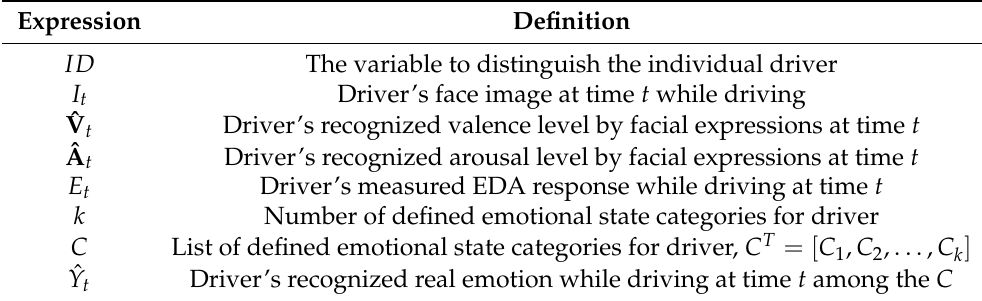
Figure 1. Overview of the proposed work with two major steps: FER and SFER. Table 1. Terminologies and definitions of the variable used in this